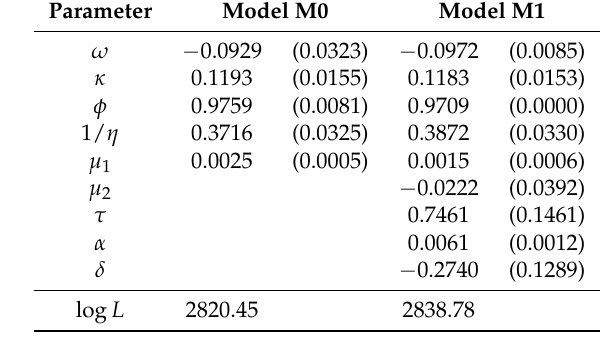
Table 1. Estimation results for the model without (M0) and with (M1) sentiment index. Standard errors are in parentheses. log L is the value of the log likelihood function.